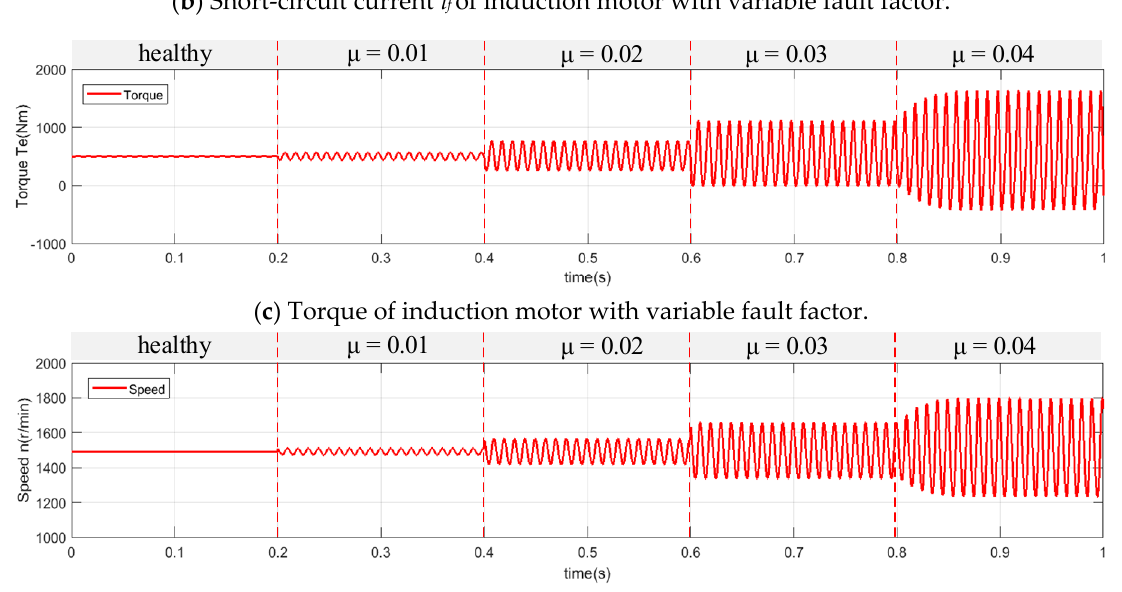
Figure 5. Simulation results of faulty state switching based on fault injection.